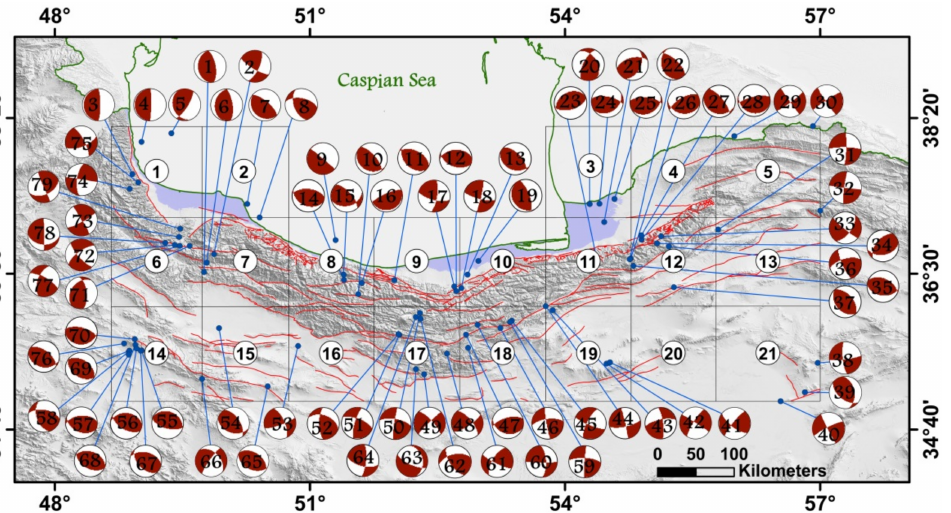
Figure 2. The earthquake focal mechanisms in northern Iran during 1978–2020 from various cata- logues. Labels on the focal mechanism refer to the first column of Table 1. Labels within grids show grid